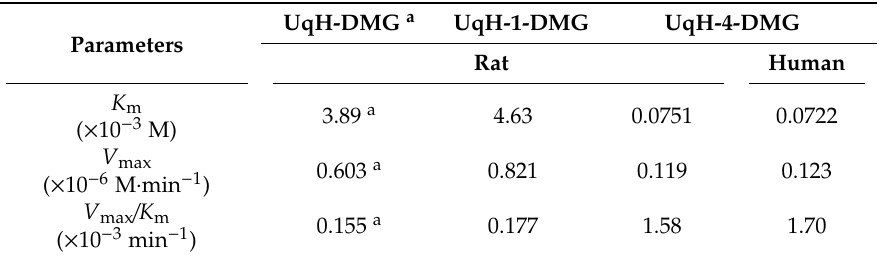
Table 1. Kinetic parameters for hydrolysis of UqH-DMG, UqH-1-DMG and UqH-4-DMG in rat and human liver microsomes at pH 7.4 and 37 ◦